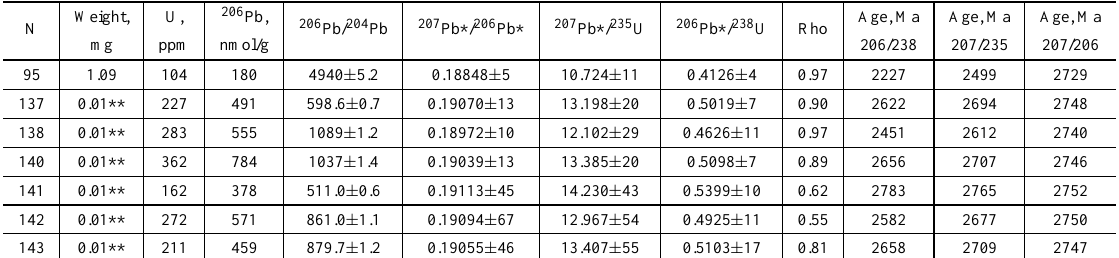
Results from U-Pb analyses of zircon 10979 of volcanic rock, Grão Pará Group, Carajás Province.